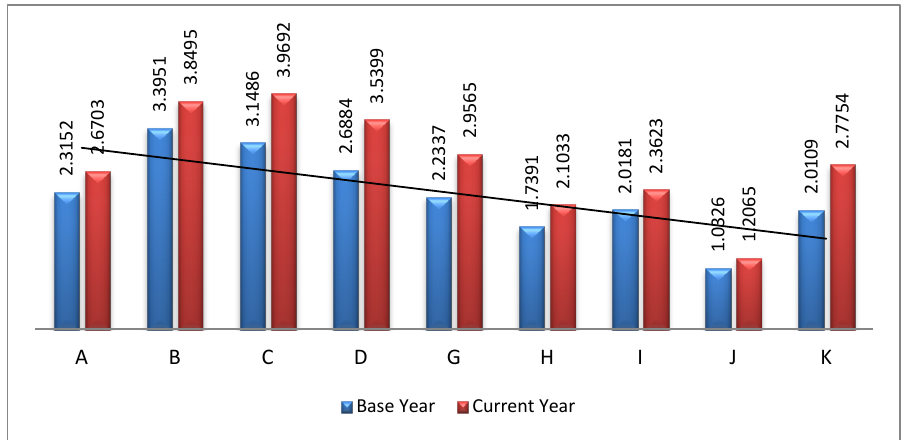
FIGURE 4: Level of reporting by new indicators Source: Authors’ analysis